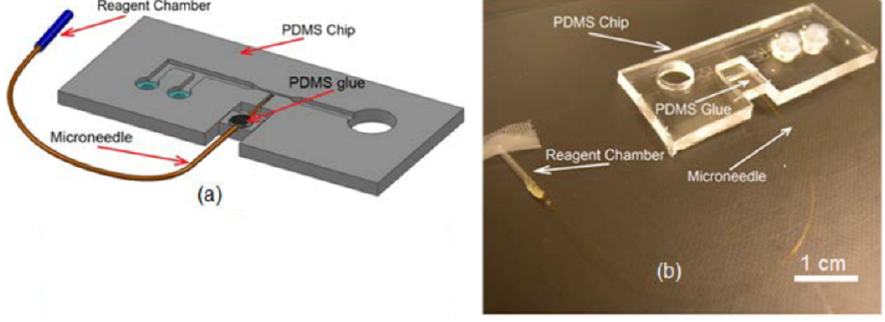
Figure 8 ( a ) A schematic of the needle assembly processes and different parts of the chip. ( b ) The PDMS chip after needle assembly. PDMS chip after needle